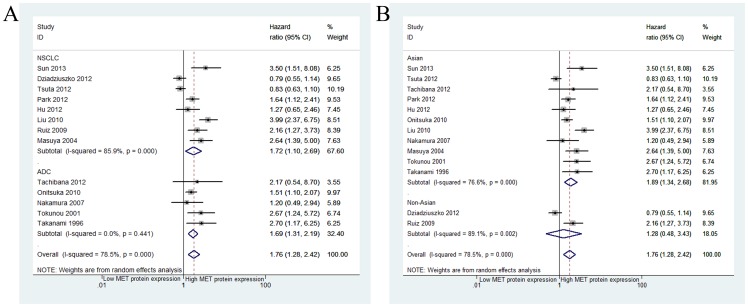
Forest plot (A) assessing MET protein expression in NSCLC stratified by histological subtypes; Forest plot (B) assessing MET protein expression in NSCLC stratified by ethnic source.